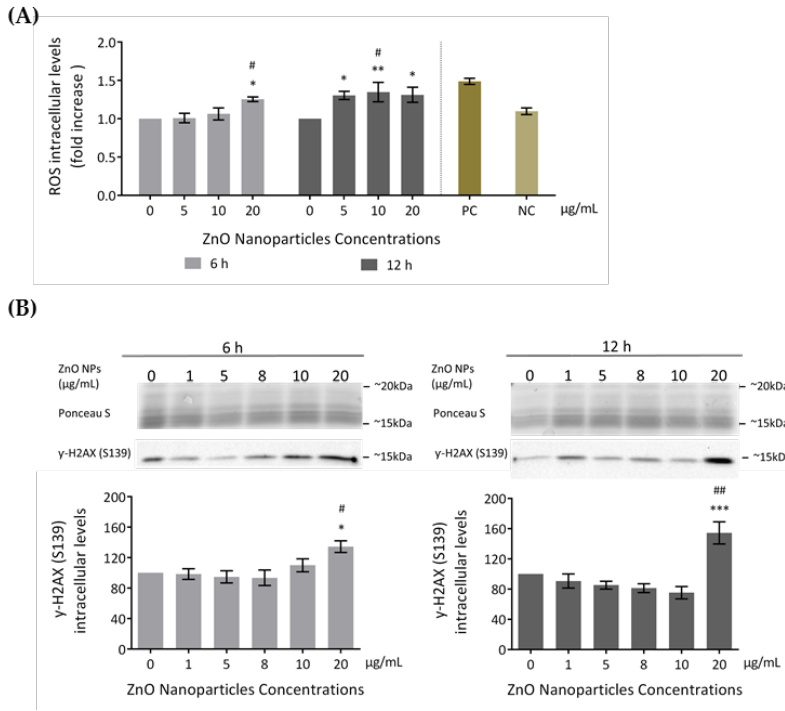
Figure 4. Cell damage induced by ZnO NPs: ( A ) Oxidative damage. Reactive Oxygen Species (ROS) intracellular level detection using the Total ROS Detection kit (ENZO Life Sciences) after the exposure of GC-1 cells to different concentrations of ZnO NPs. Positive and negative controls were performed using pyocyanin and N -acetyl- L -cysteine (NAC), respectively. The ROS levels were plotted as fold increase over the control (cells without ZnO NPs) for both 6 h and 12 h. The values for each condition were presented as a mean ± SEM of four independent experiments. ( B ) DNA damage: Analysis of γ -H2AX (Ser 139), a marker of DNA damage, by immunoblotting in GC-1 cells treated with di ff erent concentrations of ZnO NPs for 6 and 12 h. Protein levels are presented as a fold increase (%) over controls, which was plotted as mean ± SEM of four independent experiments. * For comparisons between concentrations and time points, two-way ANOVA was used. # For comparisons between